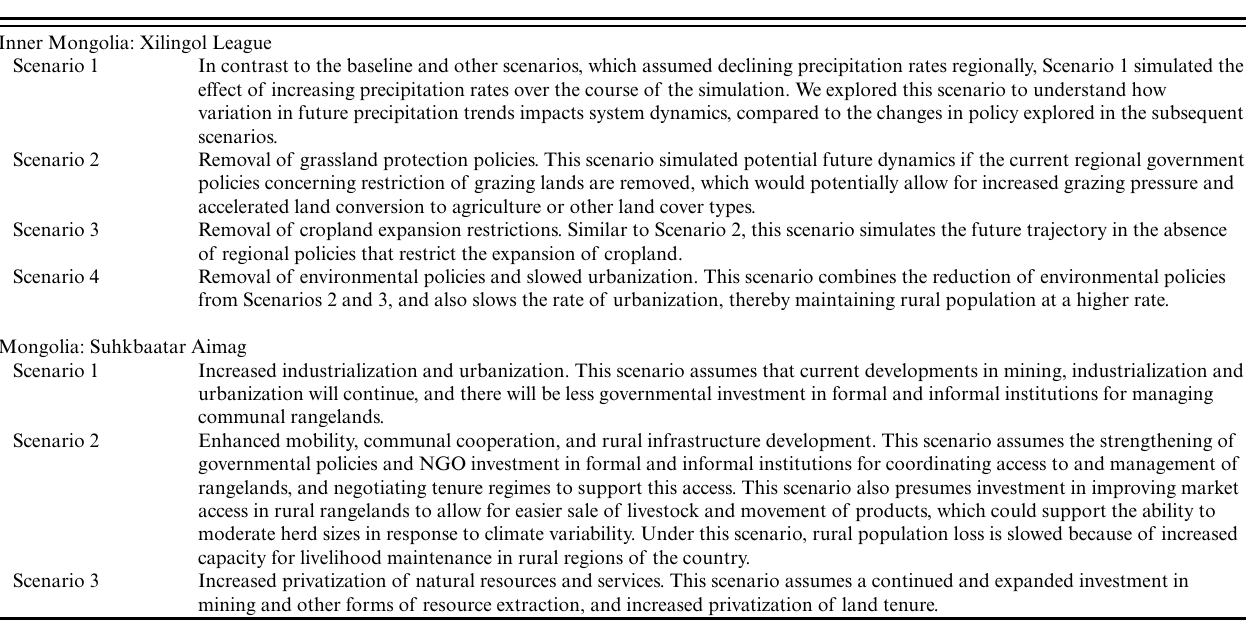
Table 1 . Description of the individual future scenarios applied to the system dynamics model for each case study area (from Allington et al.